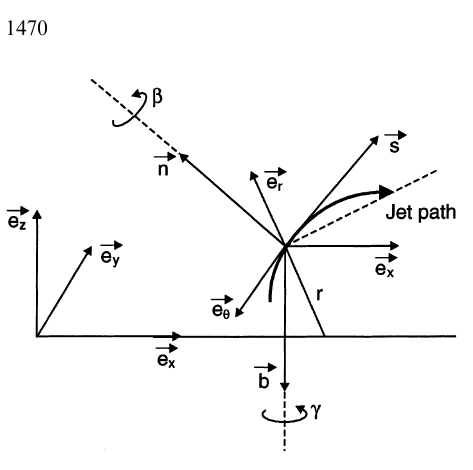
Fig. 1. Jet/wake interaction model: curvilinear frame